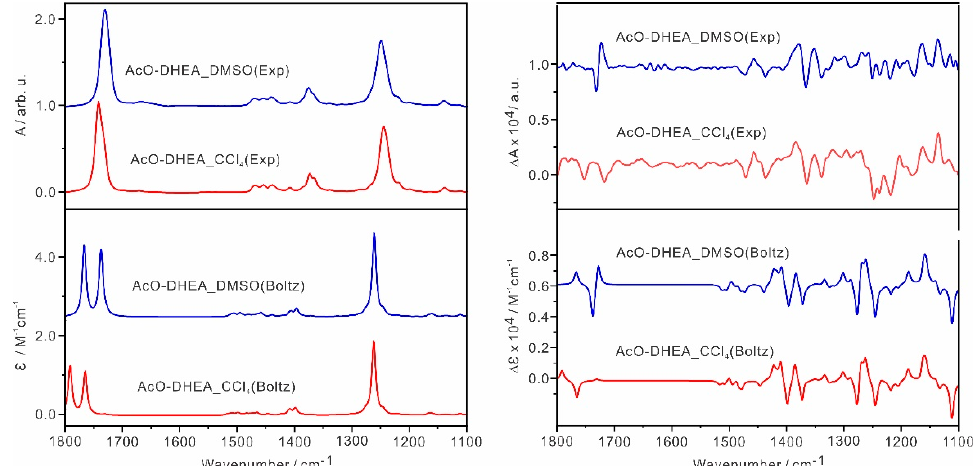
Figure 7. Comparison of the experimental IR and VCD spectra of AcO − DHEA in DMSO (blue) and in CCl 4 (red) and the corresponding Boltzmann averaged spectra at the B3LYP − D3BJ/def2 − TZVPD level of theory with the inclusion of PCM of DMSO and CCl 4 at 298 K.